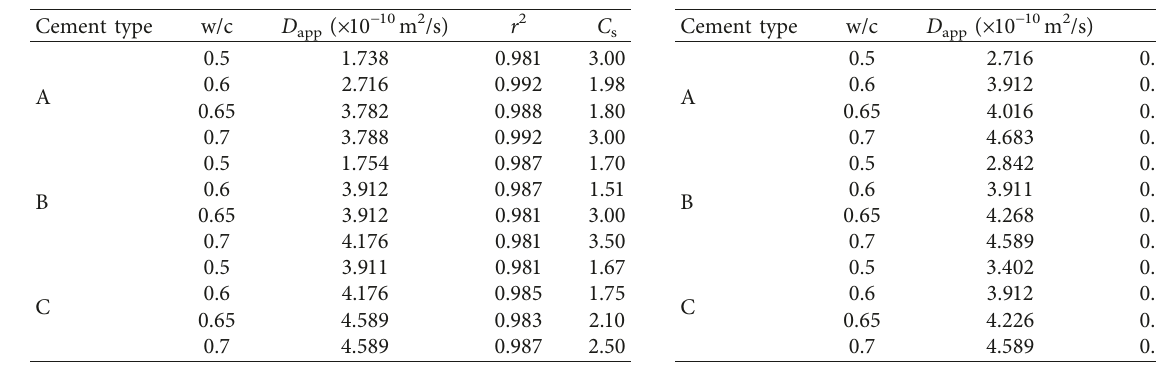
� 3.788 × 10 − 10 m 2 /s, and R 2 � 0.9992. app 2 values after exposure to WLI for Cl − app and r